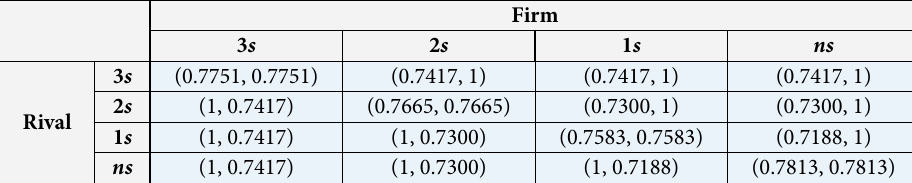
Table 13. Technological transition: four observations, risk-neutral DM, and signals on X 1 : expected value reference setting